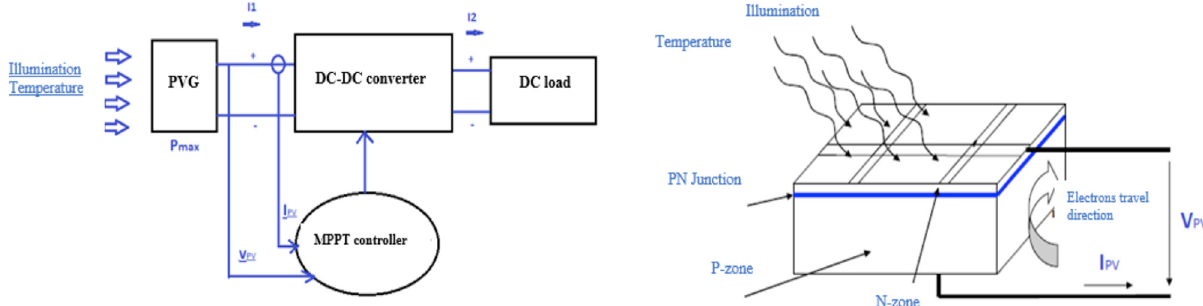
Fig. 1. Photovoltaic cell cross-section and conversion elementary chain controlled by an MPPT controller.